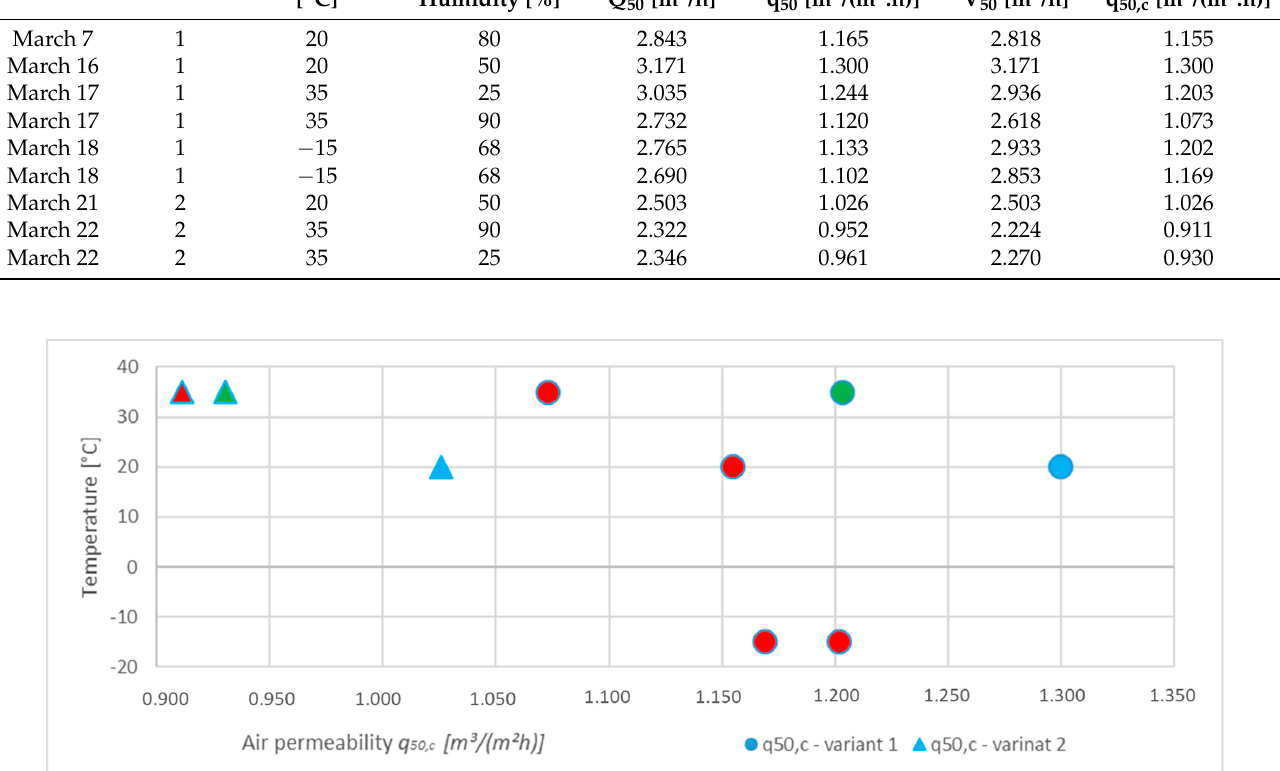
Figure 17. Results of the air permeability for variant 1 and variant 2.